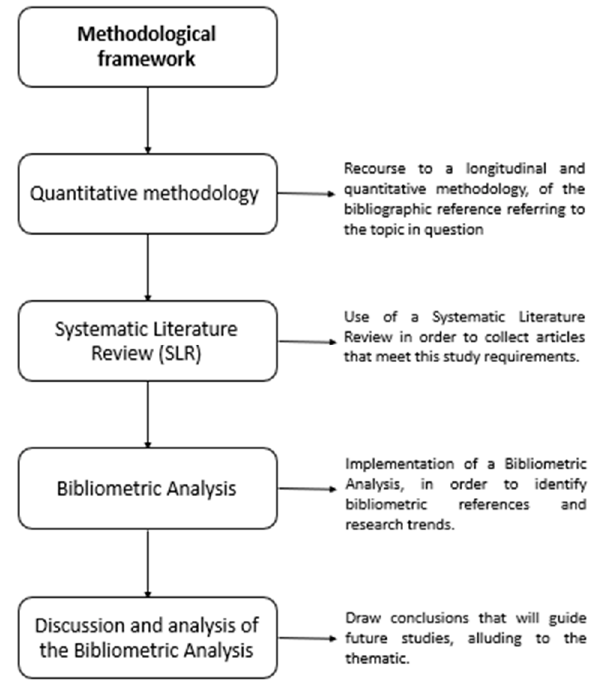
Figure 2. Summary of the methodological framework of the present study.